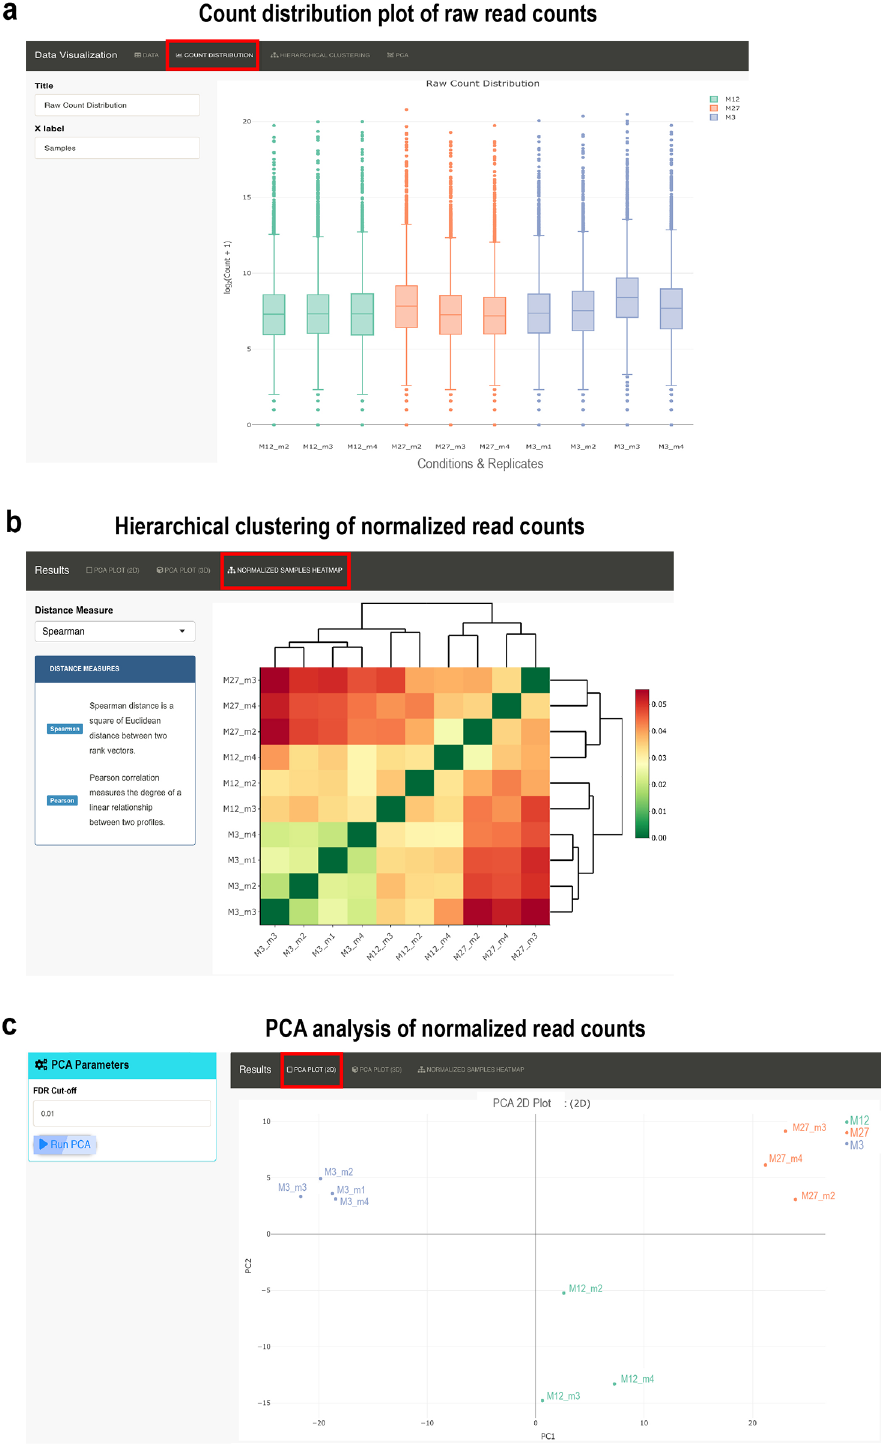
Figure 3. Data visualization plots offered in RNfuzzyApp. We used data from the Tabula muris senis project for demonstration purposes. (a) Count distribution plot of mice from 3 months, 12 months and 27 months. Only replicatesfrommalemicewerechosen.Dataaregroupedbycondition.Thetitleoftheplot,aswellastheX-axislabel can be chosen by the user. Raw read counts were chosen for visualization. (b) Hierarchical clustering of normalized read counts. Spearman correlation was used for clustering. (c) PCA plot of normalized read counts. The PCA plot can be visualized in 2D or 3D. DESeq2 was used for normalization of